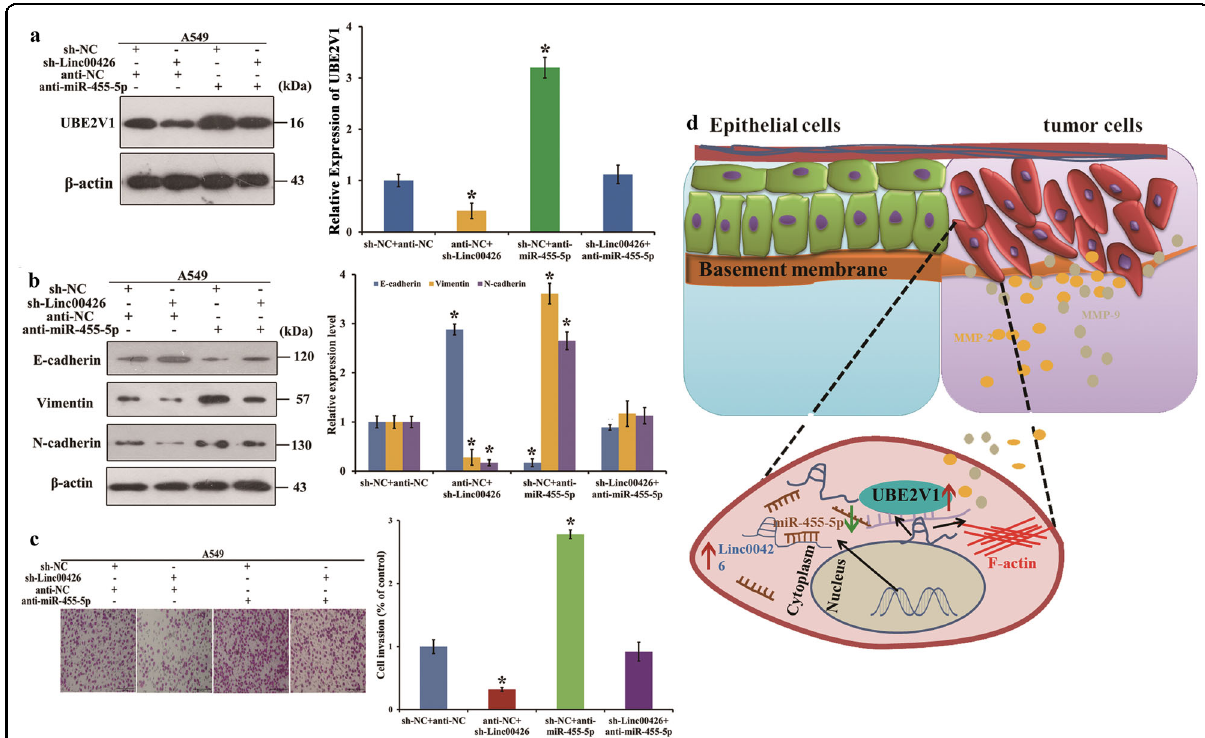
Fig. 6 Linc00426 exerts invasion activities by inhibiting miR-455-5p and up-regulating UBE2V1 expression. a The expression of UBE2V1 in different cell groups. b The expression of EMT markers in different cell groups. c The invasion ability in different cell groups. Scale bar = 100 μ m. Experiments were performed three times and data were presented as mean ± SD. * P < 0.05. One-way ANOVA. d Schematic diagram for Linc00426- based regulatory mechanisms in LUAD